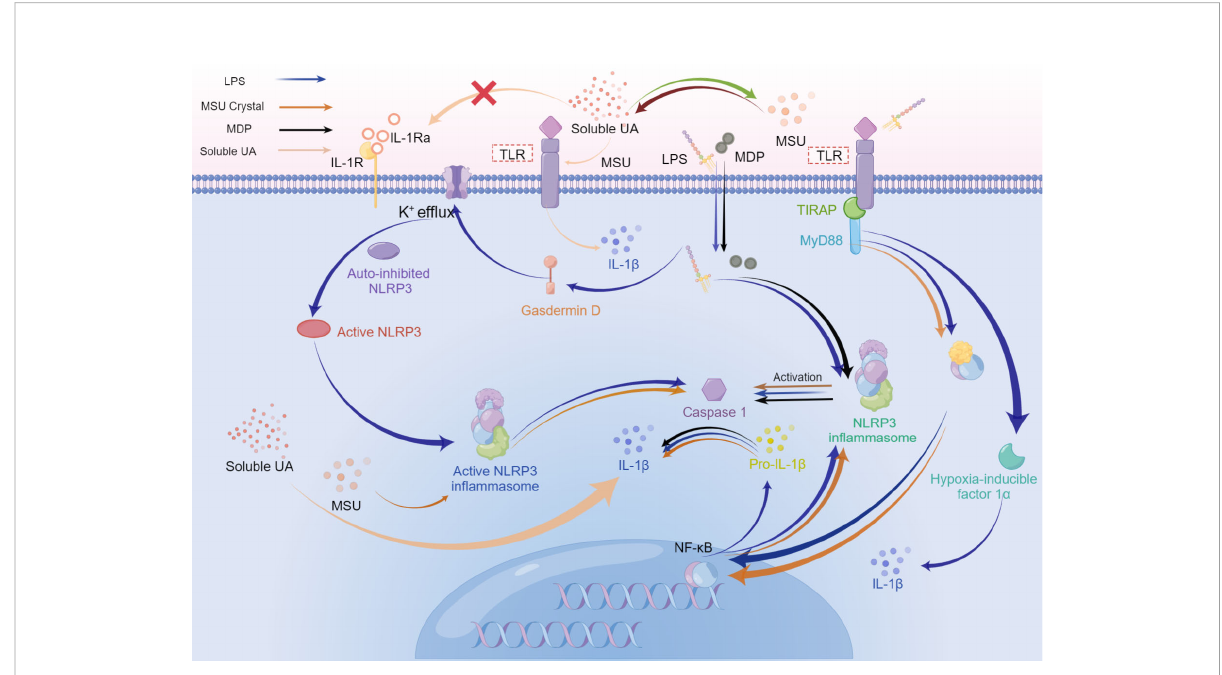
FIGURE 4 The possible superposition of bacterial in fl ammation in periodontitis and sterile in fl ammation in hyperuricemia or gout when the above diseases coexist. Activation of Toll-like receptors, especially Toll-like receptor 4, switches metabolism from oxidative phosphorylation to glycolysis in immune cells, which increases HIF- a , and enhances IL-1 b production. During the late phase of the NF- k B pathway stimulated by LPS, the fi nal effect is the upregulation of pro-resolution cytokines. LPS, MDP, and MSU initiate the assembly of NLRP3 in fl ammasome, activating caspase-1, which cleaves pro-IL-1 b into mature IL-1 b . While the production of NLRP3 is related to the MyD88-dependent pathway. Besides, IL-1 b could be promoted by simultaneous stimulation from soluble UA and MSU crystals or MSU crystals solely. Soluble UA decreases the IL-1Ra, without assistance from other stimuli. LPS activates gasdermin D, resulting in K+ ef fl ux. Subsequent assembly of NLRP3 in fl ammasome drives the activated caspase-1 cleave pro-IL-1 b into IL-1 b . Caspase-1, in turn, could stimulate gasdermin D to accelerate K+ ef fl ux, accompanying the release of IL-1 b